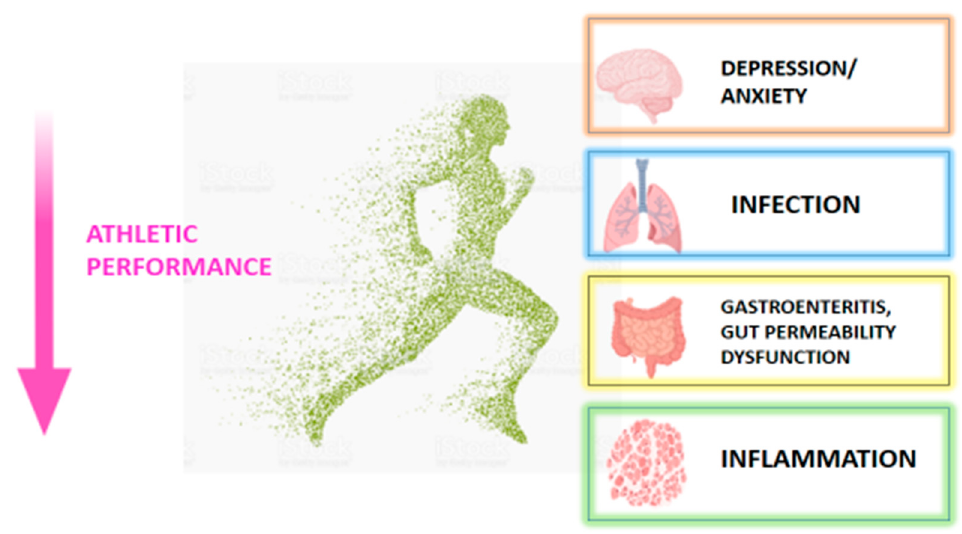
Figure 1. The e ff ects of overtraining on the wellbeing of an Figure 1. The effects of overtraining on the wellbeing of an athlete.